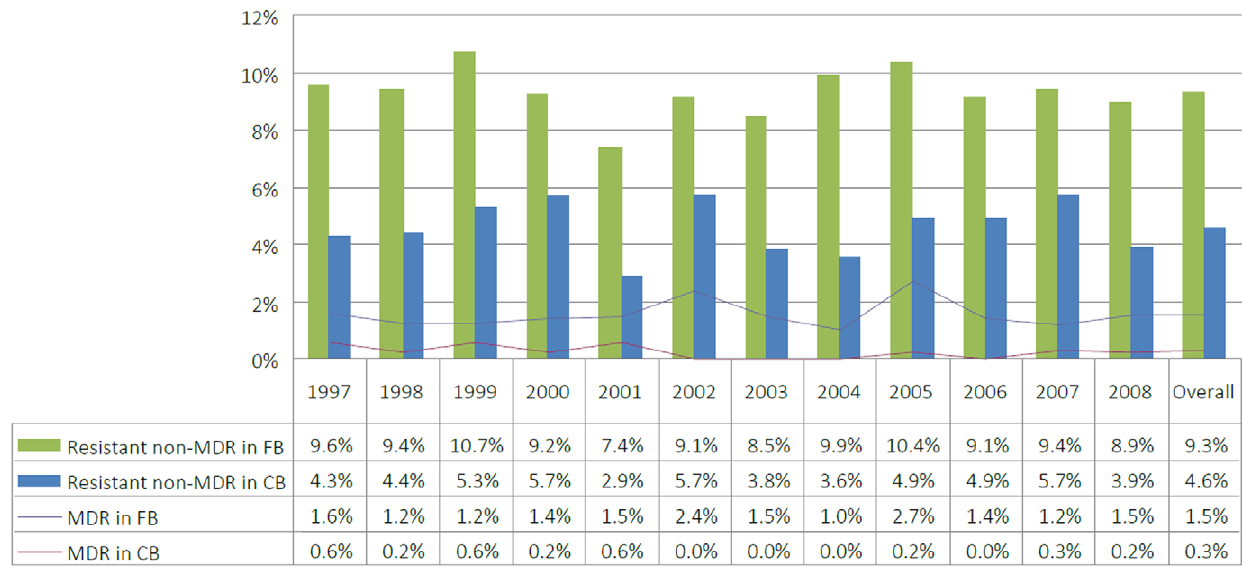
Figure 1. Proportion of culture-positive tuberculosis cases with MDR or non-MDR resistance in Canada (1997–2008). Abbreviations: FB, foreign-born; CB, Canadian-born.